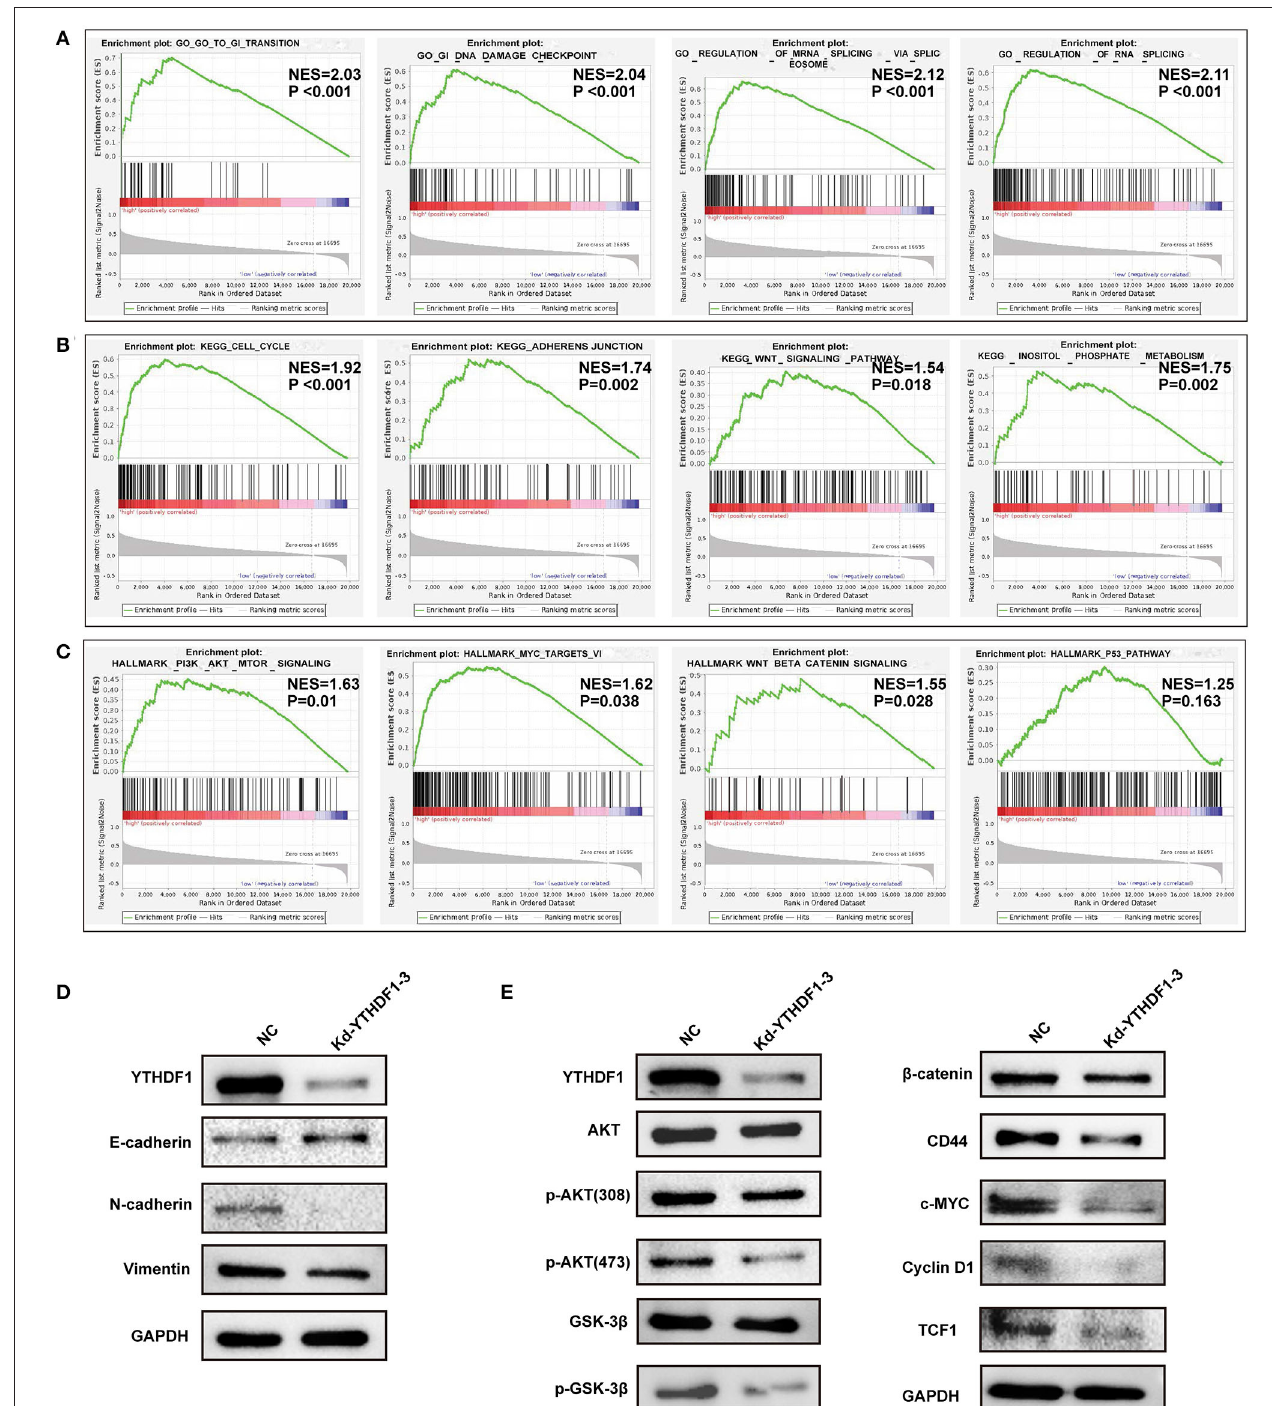
FIGURE 7 | YTHDF1 promoted epithelial–mesenchymal transition (EMT) and AKT/glycogen synthase kinase (GSK)-3 β / β -catenin signaling of hepatocellular carcinoma (HCC) cells. (A–C) Gene set enrichment analysis (GSEA) was conducted to predict the potential functions and pathways regulated by YTHDF1 based on The Cancer Genome Atlas (TCGA) datasets. (D) The EMT markers were detected by Western blotting. (E) The markers of AKT/GSK-3 β and Wnt/ β -catenin were detected by Western blotting.